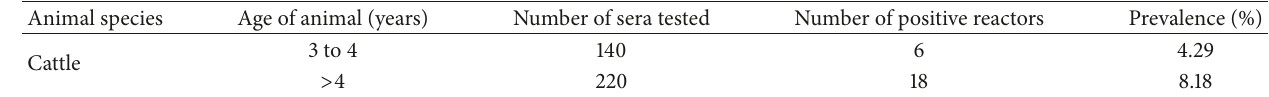
Table 3: Seroprevalence of brucellosis in cattle according to age.